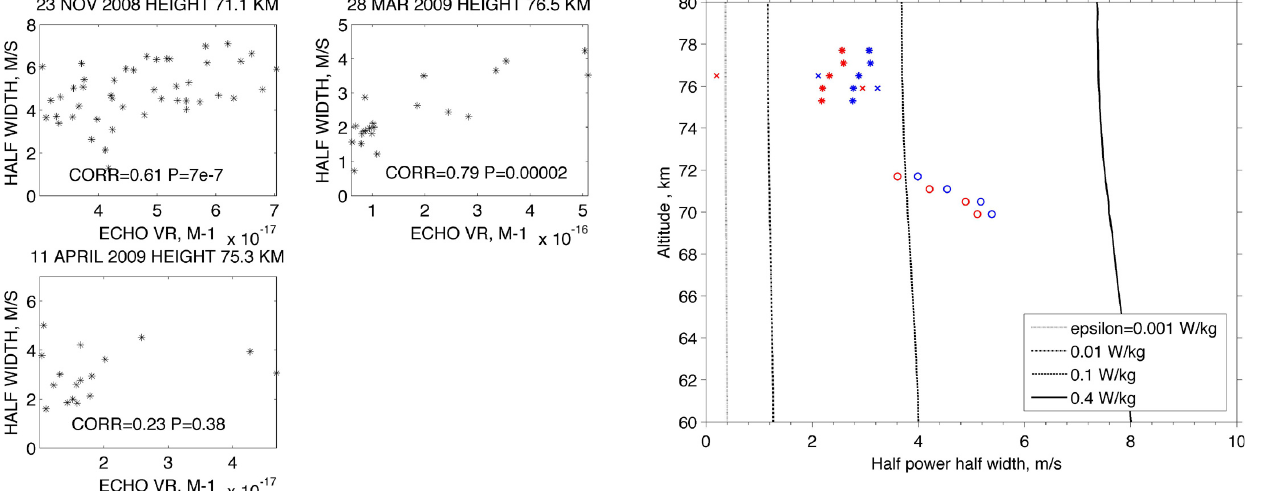
Fig. 7. Scatter plots of the half spectral width versus echo volume reflectivity at selected heights for each of three experiments indi- cated at the top. Value of correlation coefficient CORR and proba- bility P for testing the hypothesis of no correlation are indicated for each scatter plot. P is the probability of getting a correlation as large as the observed value by random chance, when the true correlation is zero.